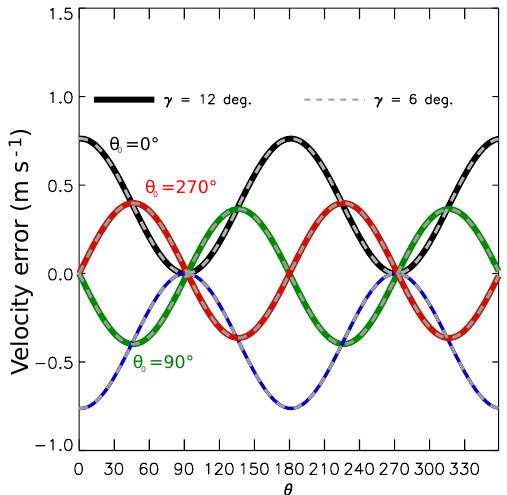
Figure B2. Velocity errors induced by satellite attitude misknowl- edge γ 0 = 0.003 ◦ , as a function of the azimuth relative to the satel- lite track, and for four examples of θ 0 . The two beams incidence angles are superimposed (thick lines: 12 ◦ ; thin dashed lines: 6 ◦ ). These errors are dominated by a contribution at twice the beam ro- tation frequency ω b